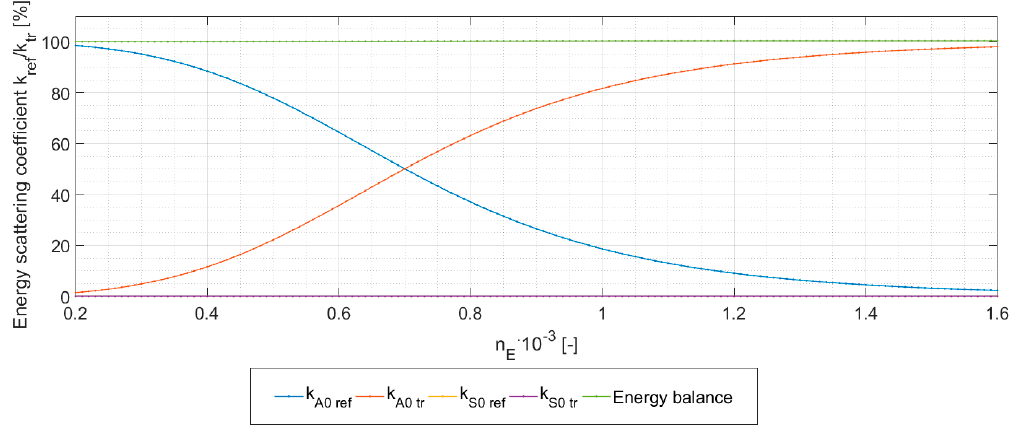
Figure 5. Energy scattering coefficients versus multiplier of Young´s modulus n E for sub-waveguide 3.